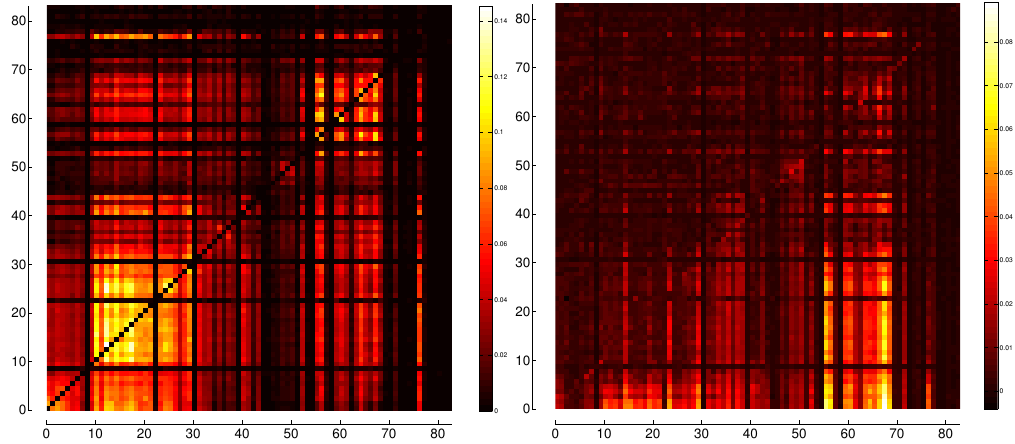
Figure 11. Heat maps of the dependency matrices built on correlation for original × original indices and for lagged × original indices,